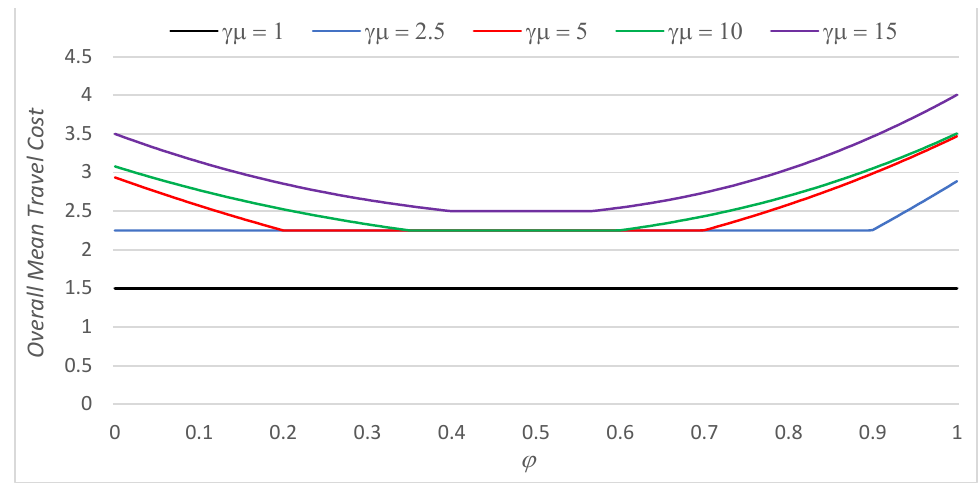
Figure 6. Long-term overall mean travel cost as a function of 𝜑 for 𝛼 = 0.9,𝛽 = 0.9 and different values of 𝛾𝜇 (case of linear link cost functions).